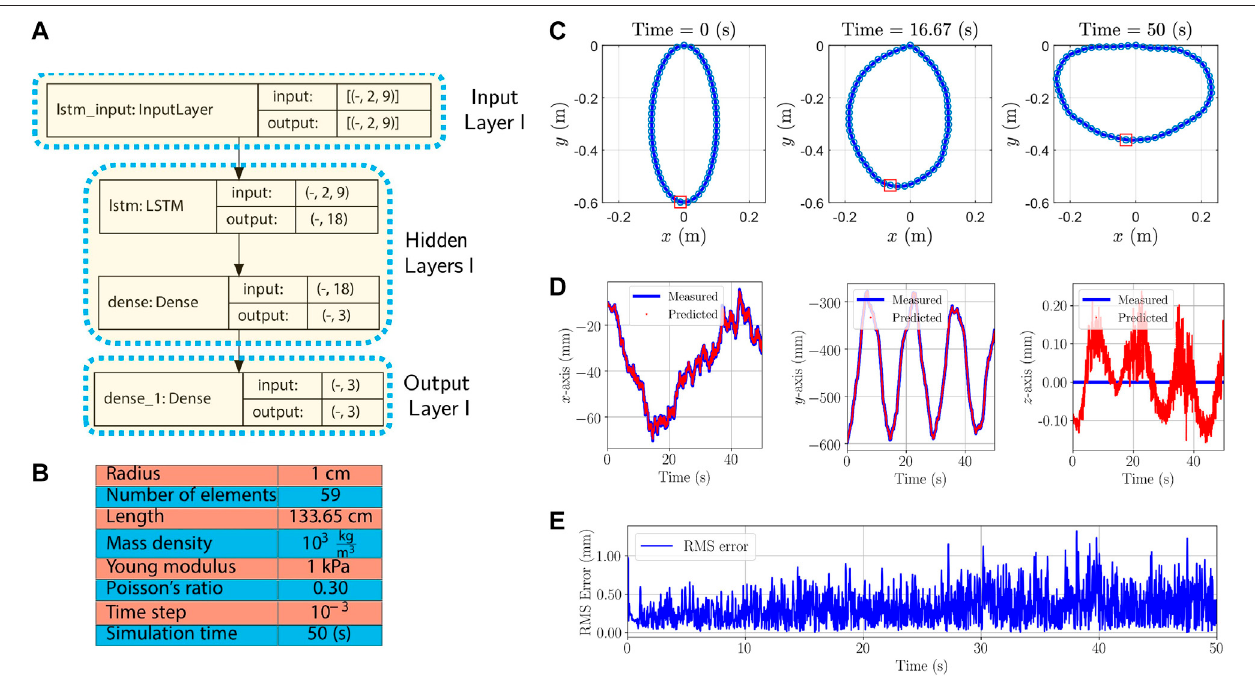
FIGURE3| First simulationexample: (A) : Themodel architecture used forthe fi rstsimulationexample.The fi rst stage isthe Inputlayer, the intermediate stages are theHidden layers,andthelaststageistheOutput layer.The fi rstdimensionofinputs andoutputs ineach layerareunspeci fi edandcanvarywiththesizeofbatches. (B) : Rod properties and simulation parameters used in the fi rst example. (C) : Initial and time-evolved con fi gurations. Positions of node speci fi ed by a red rectangle are measured and predicted. (D) : Measured position calculated from analytical dynamic model and predicted by the proposed RNN-based model in the x , y , and z -axes are given. (E) : RMS error considering all the